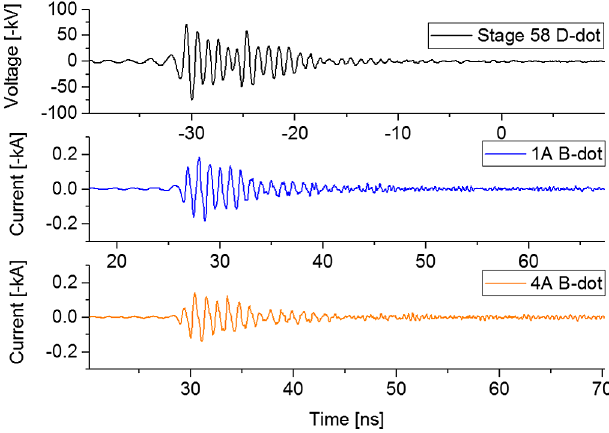
FIG. 9. FFTs of the voltage signal from the Stage 58 D-dot and the current signals from the 1A and 4A